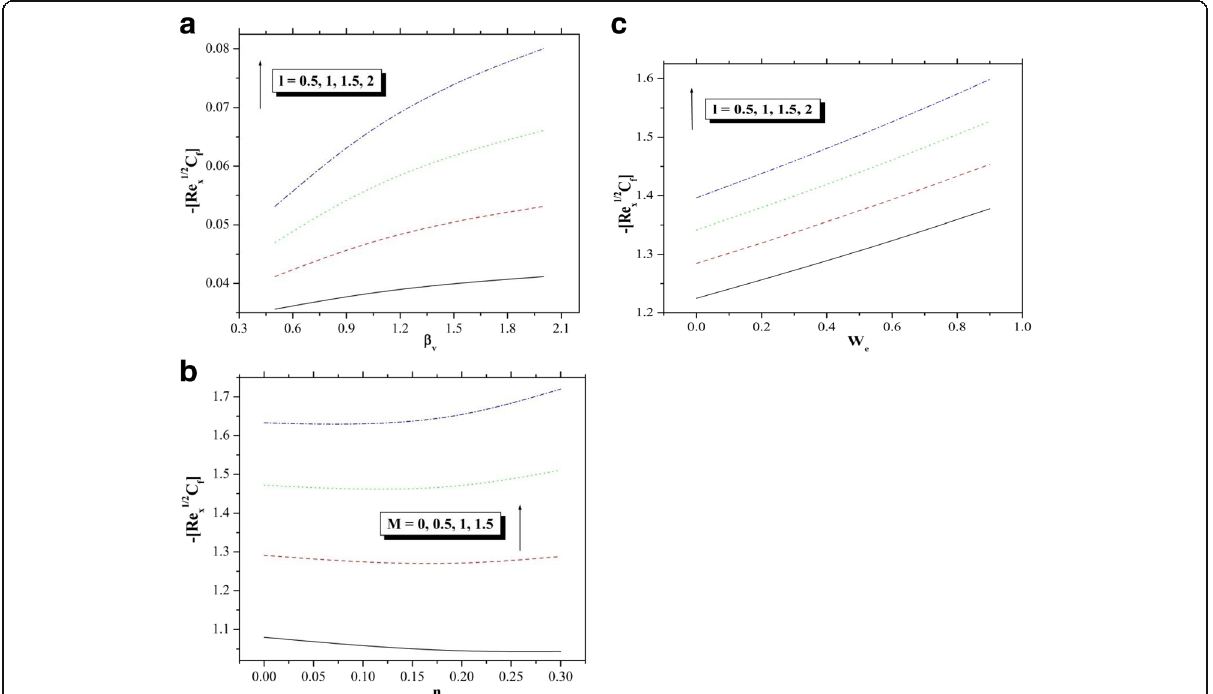
Fig. 9 a Influence of β v and l on skin friction. b Influence of n and M on skin friction. c Influence of n and M on skin friction